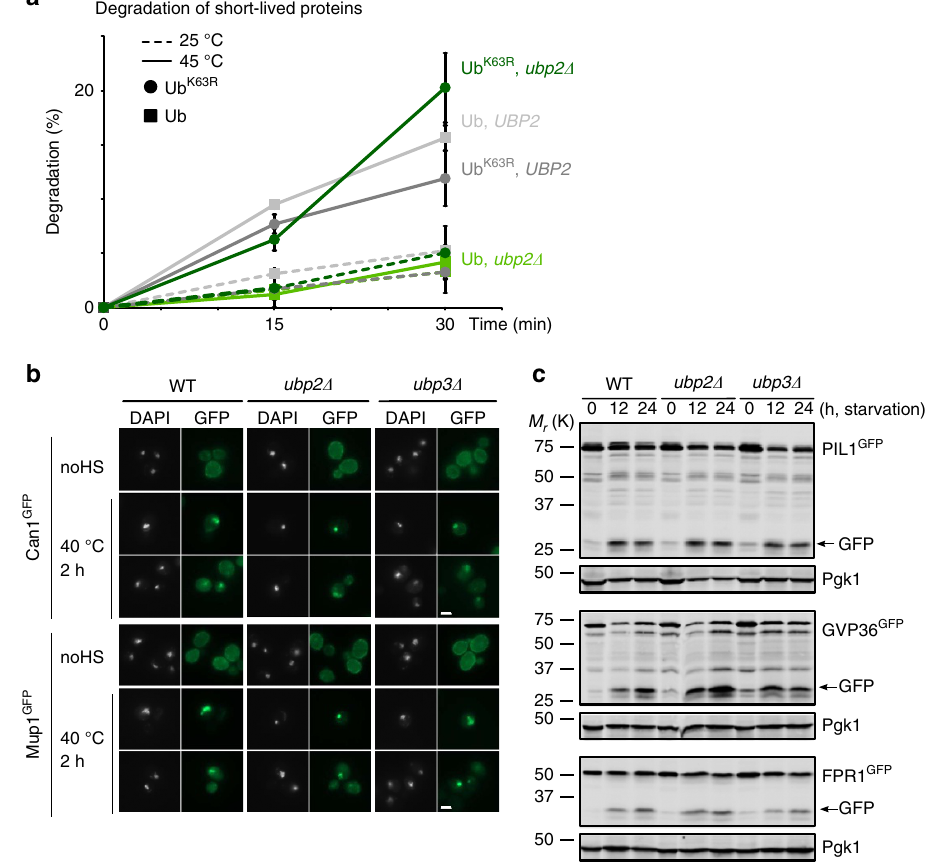
Figure 7 | Removal of K63 chains by Ubp2 and 3 mainly promotes proteasome degradation after HS. ( a ) Degradation of 35 S pulsed-labelled proteins in WT (grey) and ubp2 D (green) cells at 25 (cid:2) C (dotted lines) or 45 (cid:2) C (straight lines) that expressed solely ubiquitin (light, square) or ubiquitin-K63R (dark, round). The portion of proteins degraded at the indicated times was measured and averaged for short-lived proteins in three independent experiments (with s.d.). ( b ) Representative fluorescent microscopy images of WT, ubp2 D and ubp3 D cells that expressed Can1 GFP or Mup1 GFP from their endogenous promoters and that were incubated at 25 or 40 (cid:2) C for 2h. Both the GFP and Hoechst (DNA staining) channels are shown. Scale bar, 2 m m. ( c ) Cells that expressed the indicated aggregation-prone proteins C-terminally tagged with GFP (from endogenous locus) were starved at 30 (cid:2) C for the indicated times before western